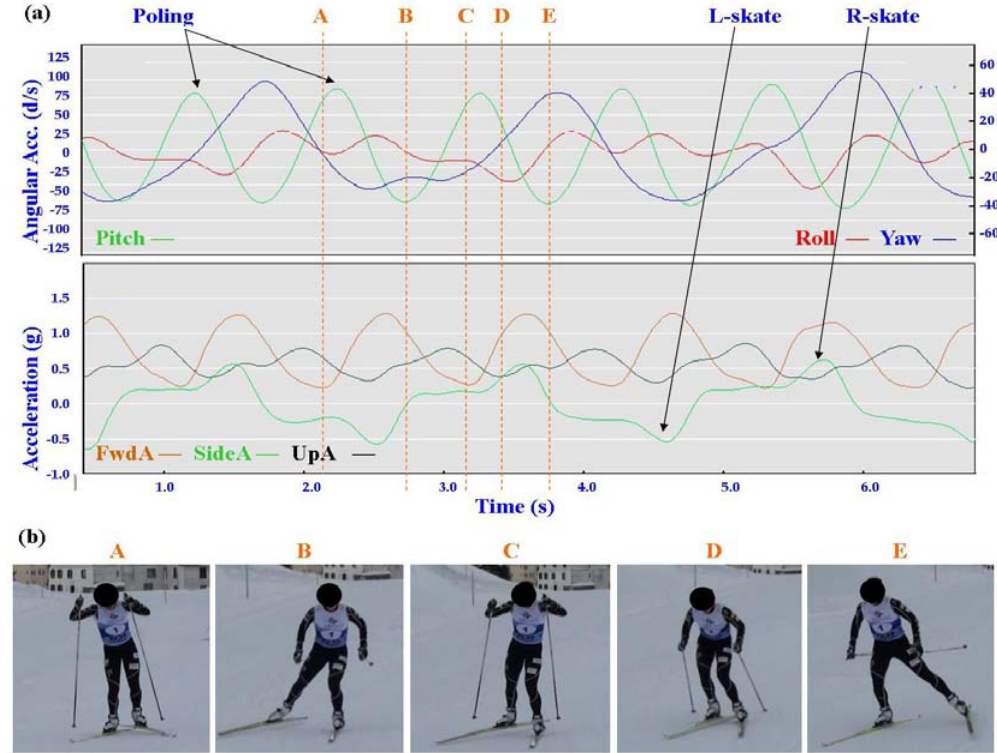
Figure 7. ( a ) Screenshot of Double Time (G3) gyroscope and accelerometer traces against time; ( b ) G3 body position for selection